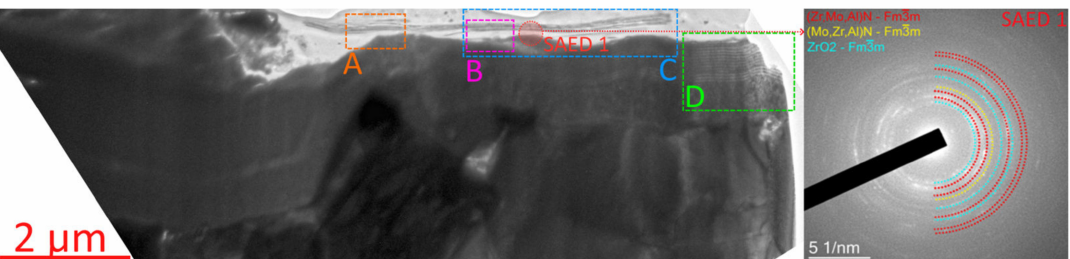
Figure 5. General view of the region, in which the wear pattern on the (Zr,Mo,Al)N coating was studied during the turning of Inconel 718 at the cutting speed of v c = 125 m/min, after 24 min of cutting. Localization of the areas of detailed studies and the results of the SAED analysis focused on the phase composition of the oxidized area of the coating (SAED